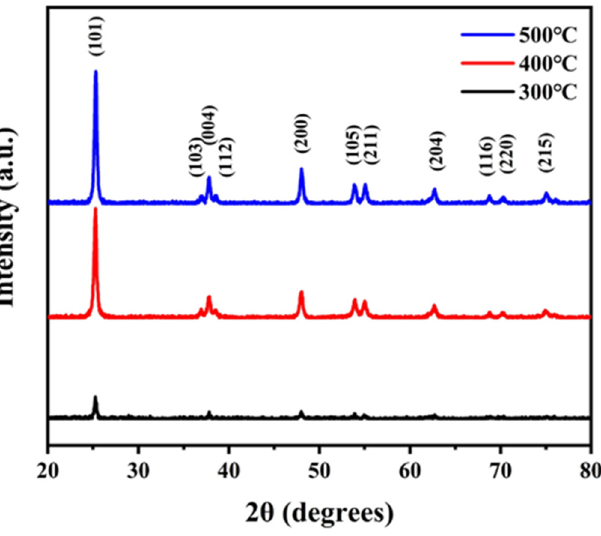
Figure 2. The XRD patterns of N-TiO 2 photocatalysts with different calcination